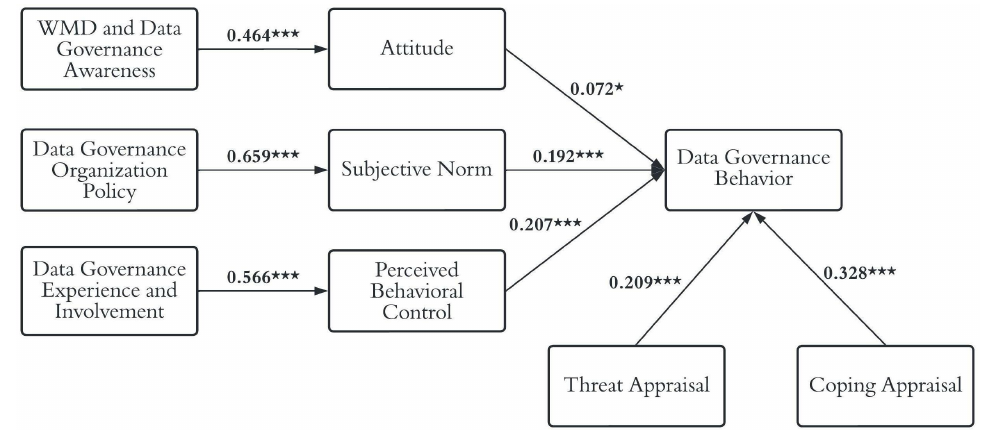
Figure 9. The results of the structural model analysis (*, p < 0.05; ***, p < 0.001). The findings show that the paths from WMD and research data governance awareness toward attitude ( β = 0.464); from data governance organization policy to subjective norms ( β = 0.659); from experience and involvement to perceived behavioral control ( β = 0.566); and attitude ( β = 0.072), subjective norms ( β = 0.192), perceived behavioral control ( β = 0.207), threat appraisal ( β = 0.209), and coping appraisal ( β = 0.328) toward data governance behavior were significant. Looking further at the effect size for each independent variable, as shown in Figure 9, it can be observed that the independent variable attitude produces the smallest effect size compared to other independent